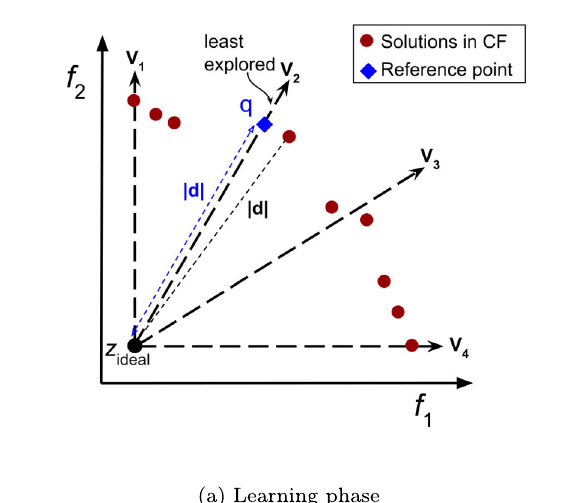
Fig. 2 Reference point as preference information in